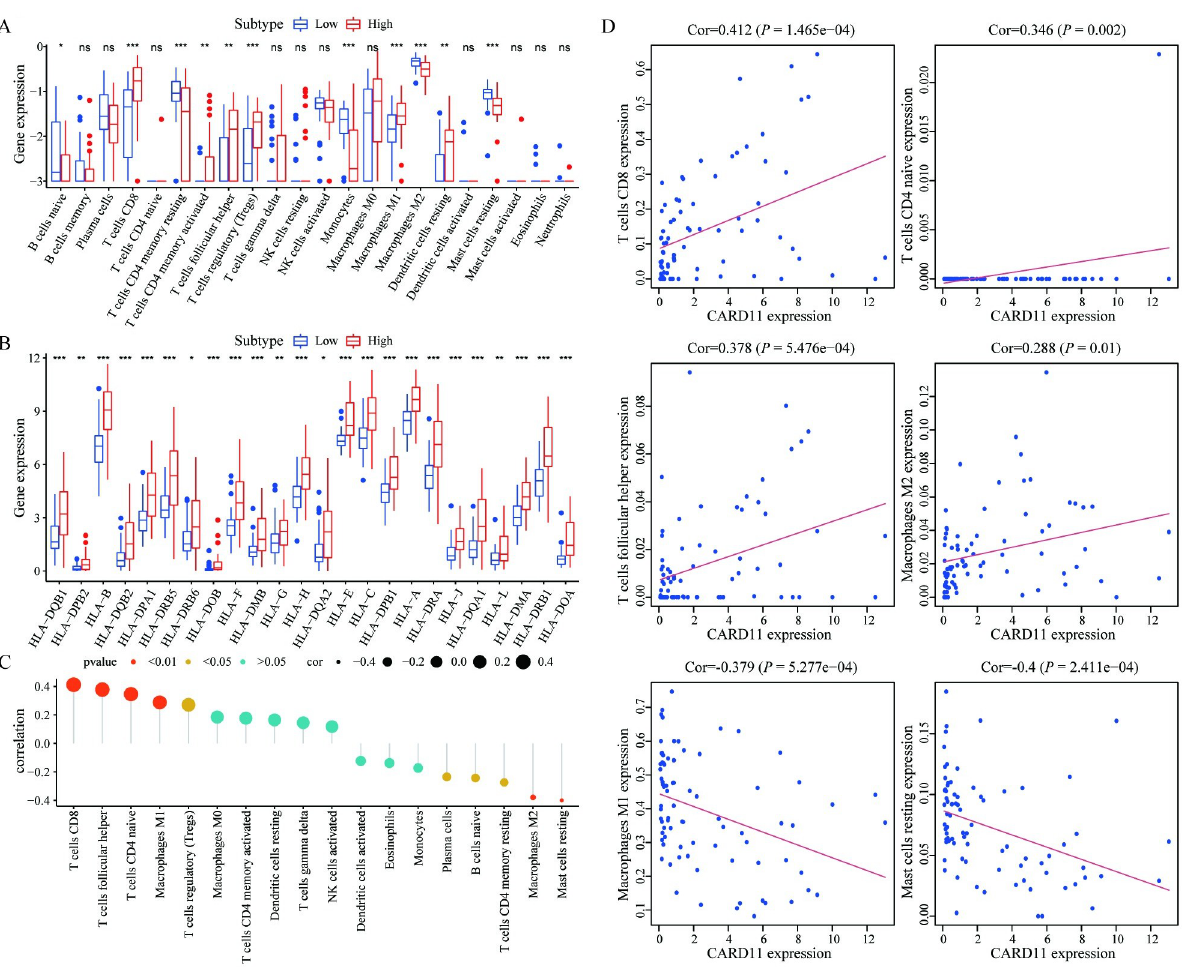
Fig 4. The correlation between CARD11 expression and immune infiltration. ( A ) Correlation analysis showed that the infiltration level of some immune cell subtypes was significantly different between the high and low expression groups. ( B ) The expression levels of HLAs were significantly different between the high and low expression groups. ( C ) Lollipop graph showed that the correlation between different immune cell subtypes and CARD11 expression. The size of the dots represents the correlation coefficient, and the color represents different levels of P values. ( D ) Analysis of immune cell subtypes significantly related with CARD11 expression.